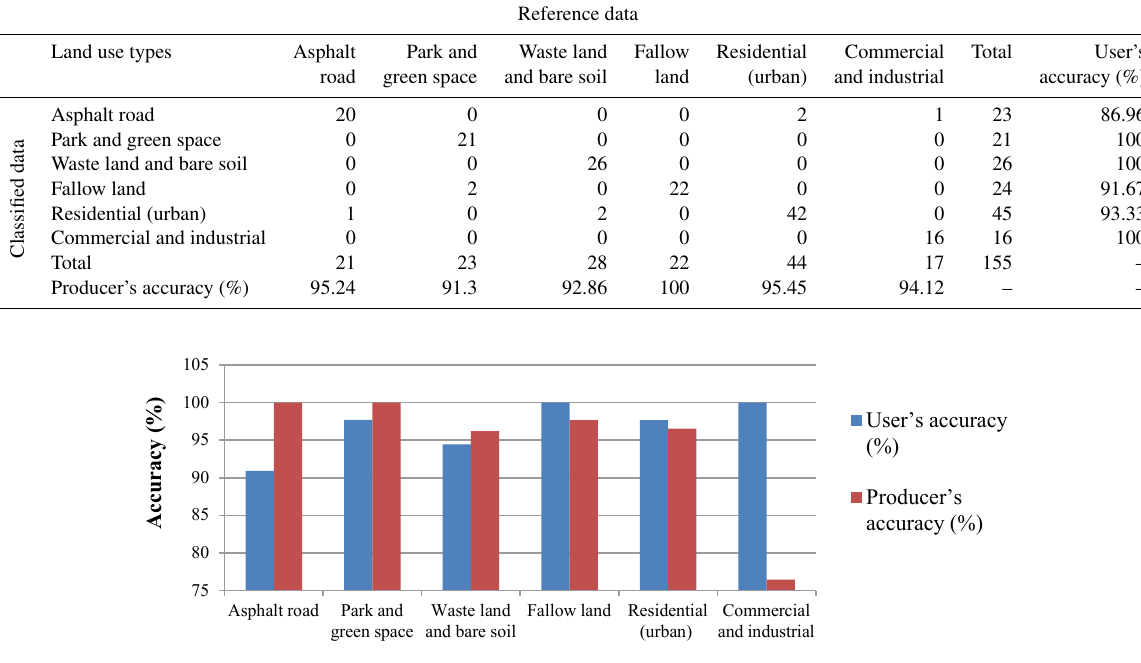
Figure 5. Land use classes User’s and producer’s accuracy of the 8 August 1998 Landsat TM image.